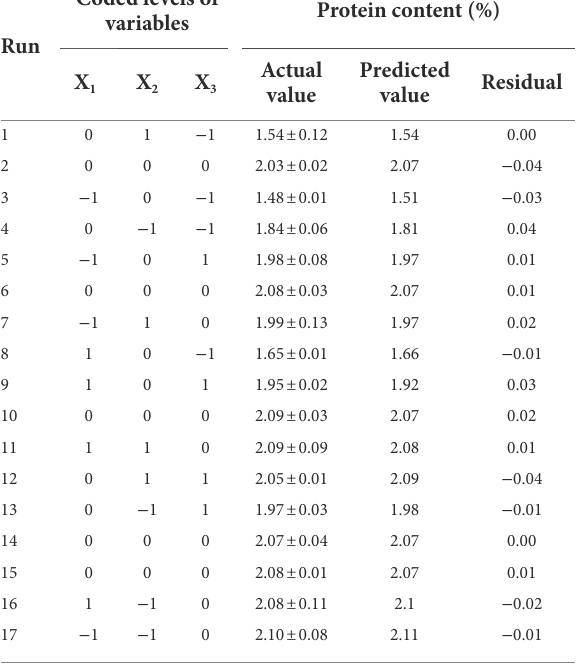
TABLE 4 Box–Behnken design with experimental and predicted values of mycelial protein content. Coded levels of variables Run